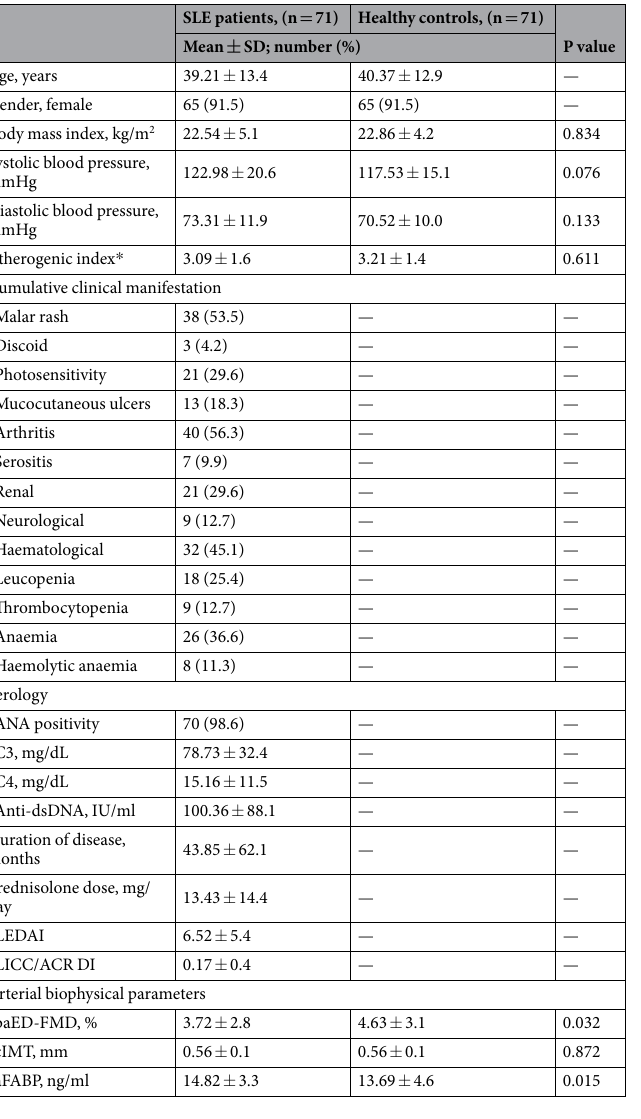
Table 1. Demographics, clinical characteristics, serological and arterial biophysical parameters of patients with SLE and healthy controls. Abbreviations: aFABP, adipocyte fatty acid binding protein; SLE, systemic lupus erythematosus; SD, standard deviation; SLEDAI, Systemic Lupus Erythematosus Disease Activity Index; SLICC/ACR DI, Systemic Lupus International collaborating clinics/ACR damage index; baED-FMD, brachial artery endothelium-dependent flow-mediated dilation; PWV, pulse-wave velocity; AI, augmentation index; cIMT, carotid intima media thickness. * Serum total